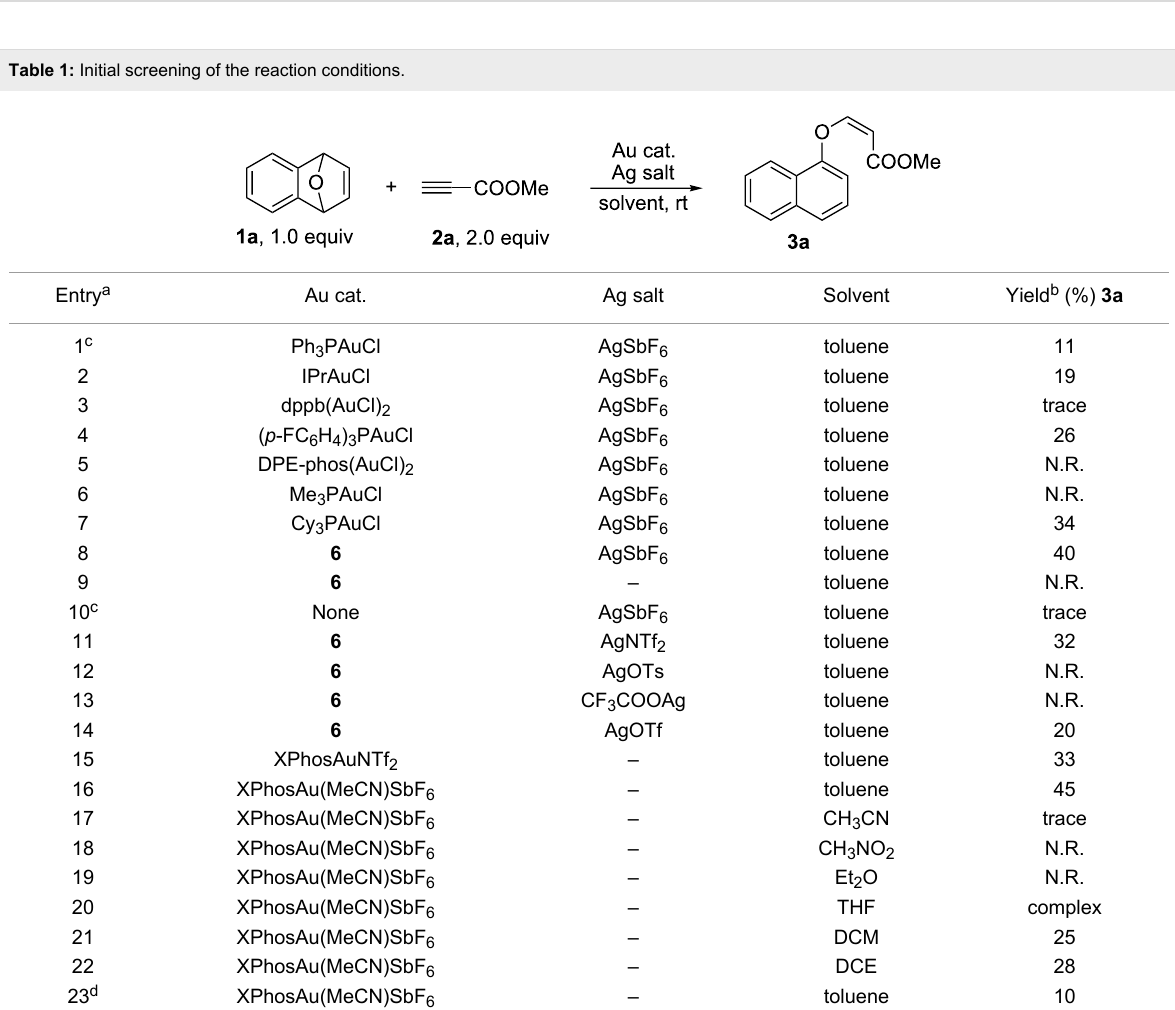
Table 1: Initial screening of the reaction conditions.